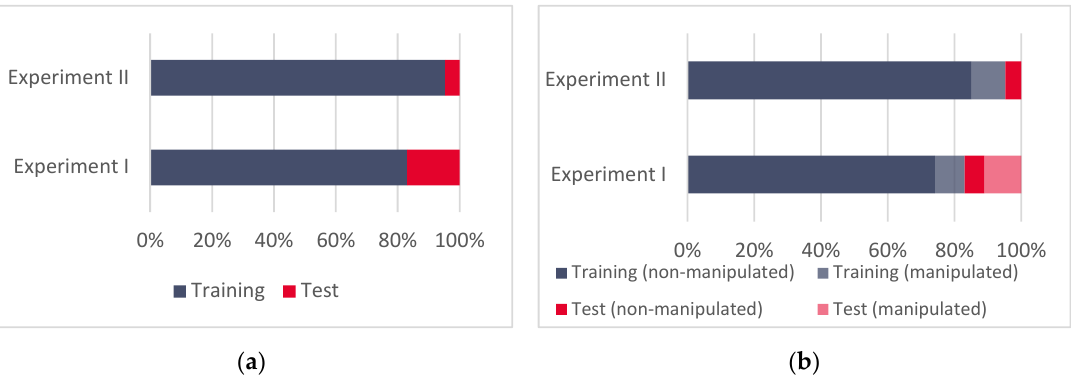
Figure 3. ( a ) Training and test datasets for Experiment I and Experiment II, and ( b ) the relative ratios of manipulated and non-manipulated GNSS records in datasets.